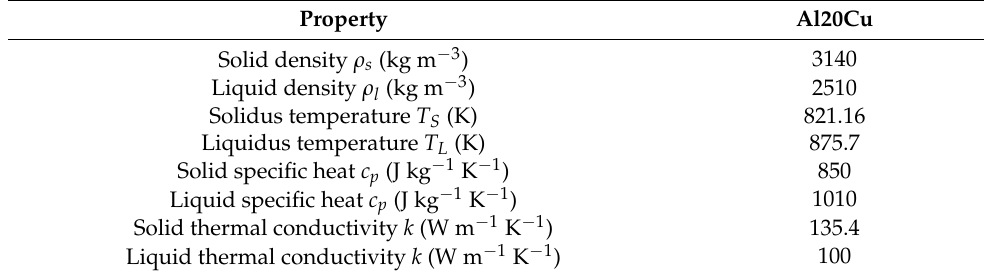
Table 2. Thermophysical properties of the material used in this simulation [33].